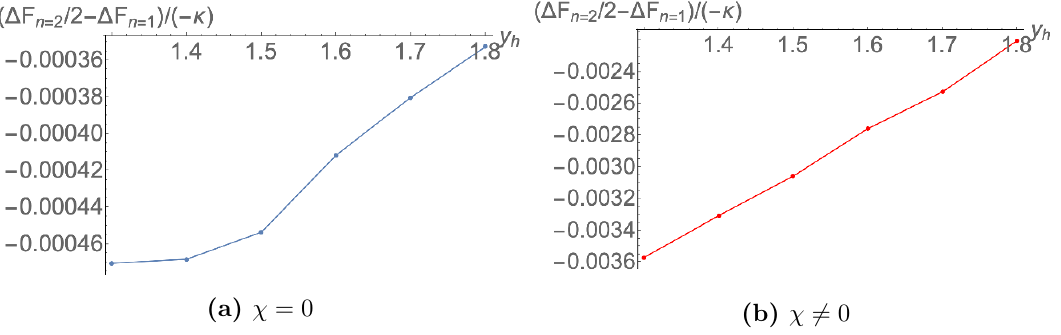
Figure 6. Check of vortex type with same parameters as above, qL = 2. For these parameters these solutions are of type